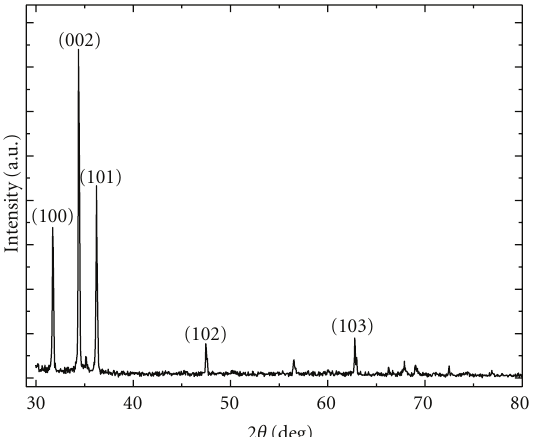
Figure 3: Typical XRD pattern of ZnO NTs.